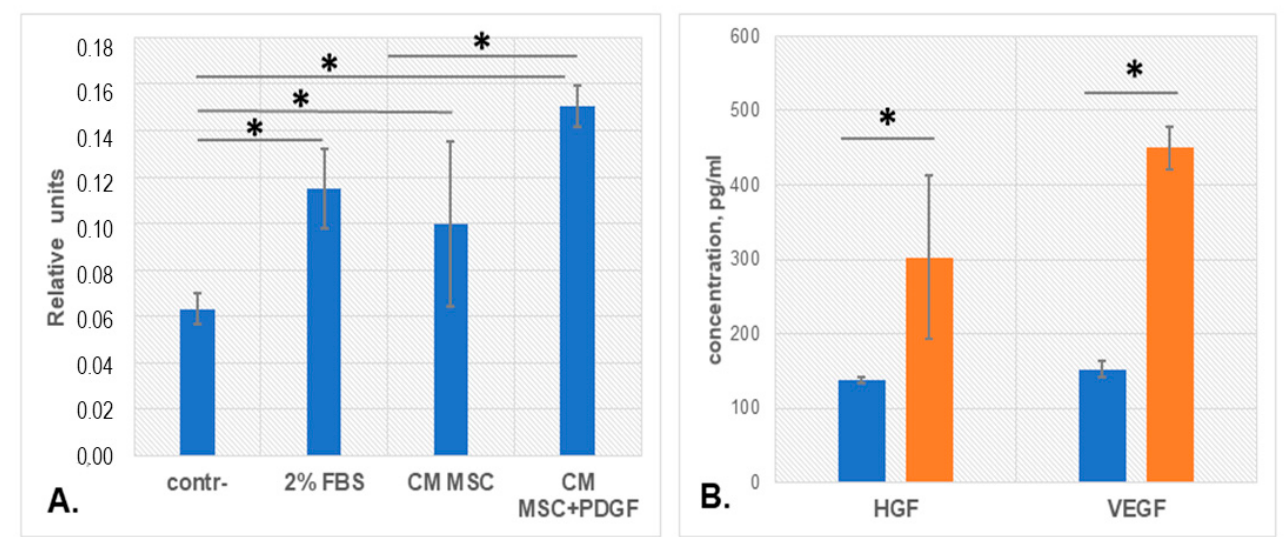
Figure 5. Analysis of MSC pro-angiogenic effects after PDGF-BB treatment. ( A ) The slope (cell index, CI/hour) of HUVEC migrating in the CIM plate of RTCA xCELLigence system towards medium conditioned by MSC (CM MSC) or medium conditioned by MSC after PDGF-BB treatment (CM MSC + PDGF). ( B ) Concentration of growth factors HGF and VEGF in CM MSC (blue) and CM MSC + PDGF (orange). All experiments were performed using cells from three healthy donors in duplicates. Data are presented as mean values of three independent experiments, error bars—standard deviation SD, * p < 0.05.